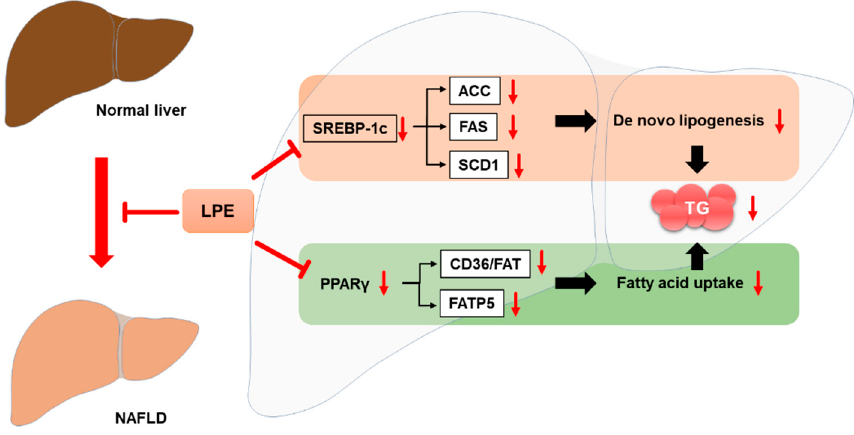
Figure 8. Schematic diagram of potential improvement mechanisms of HFD-induced NAFLD by LPE.